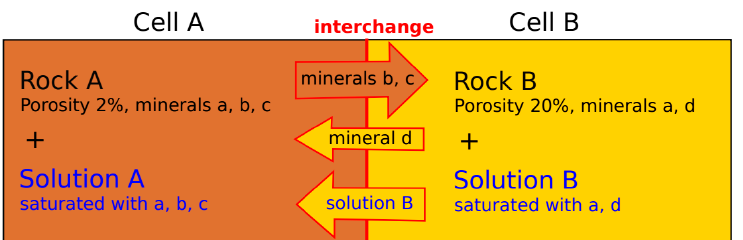
Figure 4. Sketch of the implemented interchange approach. A defined amount of minerals accord-